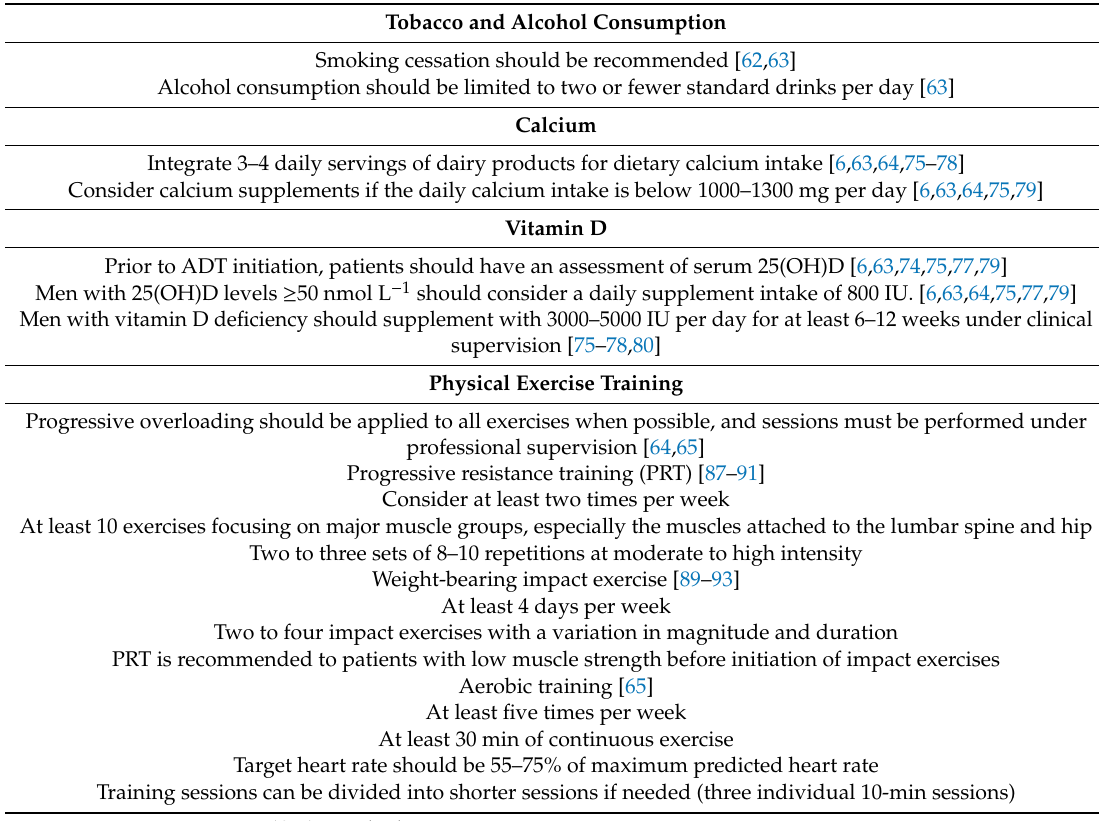
Lifestyle modifications and physical training recommendations for managing androgen-deprivation therapy-related adverse